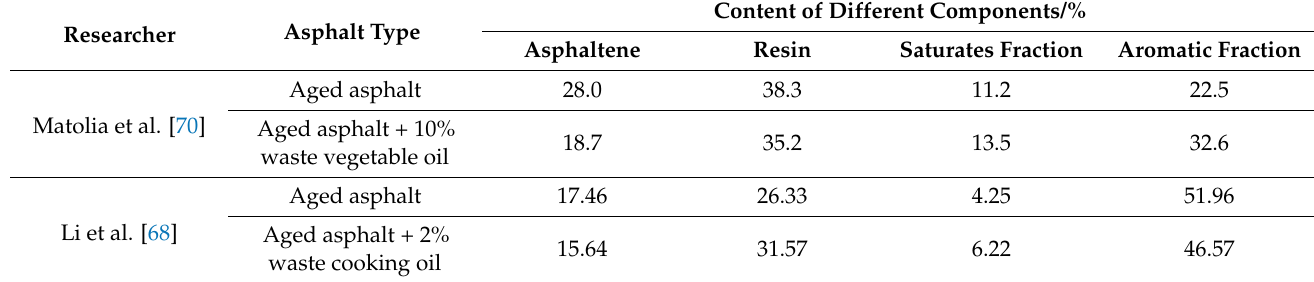
Table 17. Components of aged asphalt and